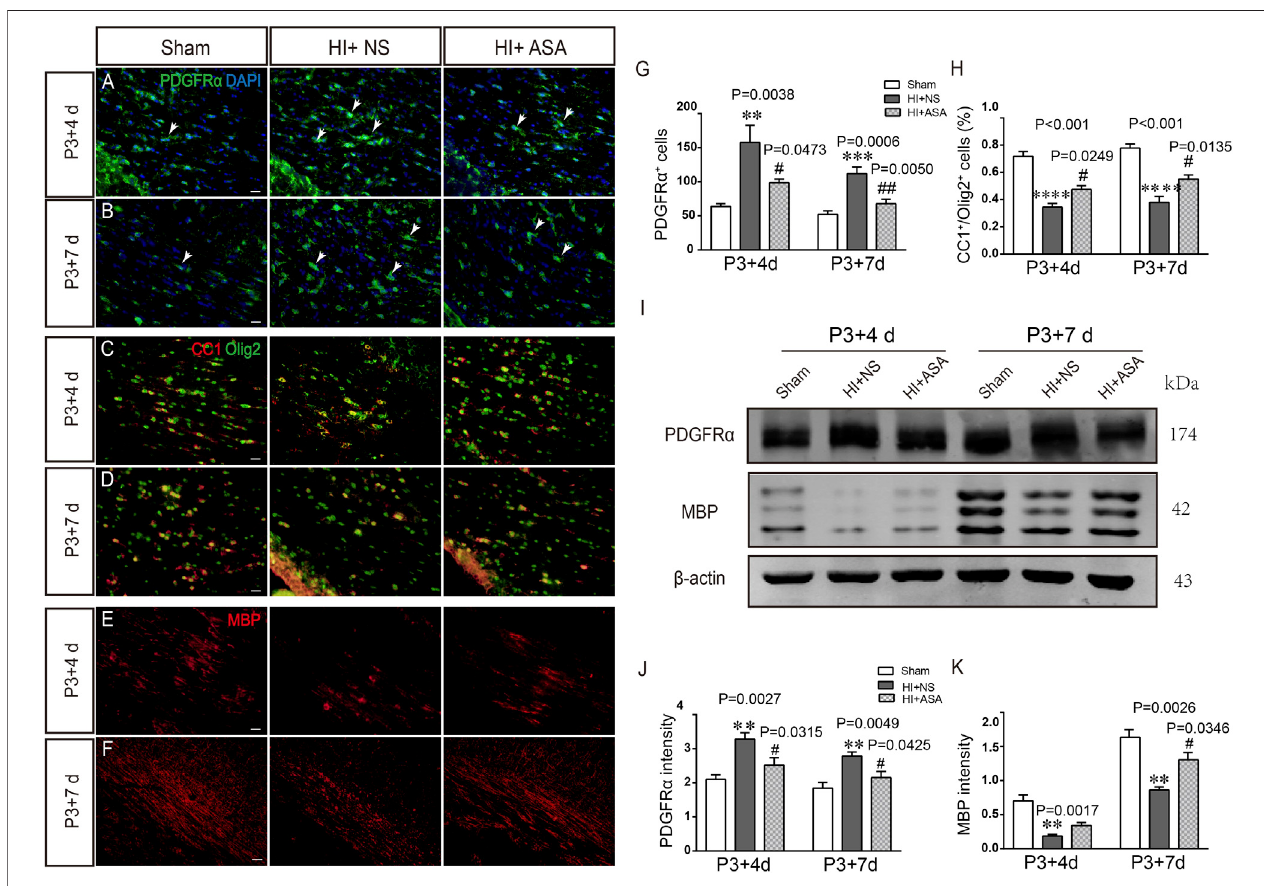
FIGURE 2 | α -Asaronol improves OPC differentiation and relieves dysmyelination in PWMI models. Representative immuno fl uorescence images for PDGFR α - labeledOPCs. (A,B) CC1-labeledmatureoligodendrocyteandOlig2-labeledoligodendrocytelineage (C,D) andMBP-labeledmyelinsheath (E,F) inthecorpuscallosum atP3+4 dandP3+7 dafterHI.Scalebar,20 µm. (G,H) Quanti fi cationofthenumberofPDGFR α + cellsandthepercentageofCC1+/Olig2+cells. (I,K) Westernblotting wasperformedtoanalyzePDGFR α andMBPproteinlevels.Alldataareexpressedasthemean±SEM. **p < 0.01, ***p < 0.001, ****p < 0.001vs.shamgroup. # p < 0.05, ## p < 0.01 vs. HI + NS group. N = 4 for each